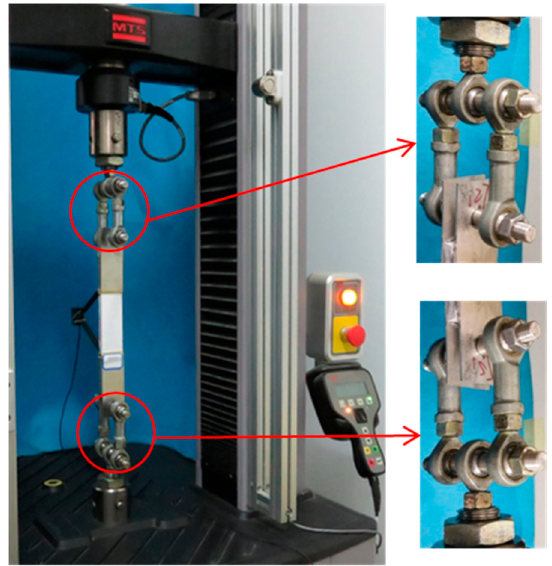
Figure 4. Uniaxial tensile test setup.